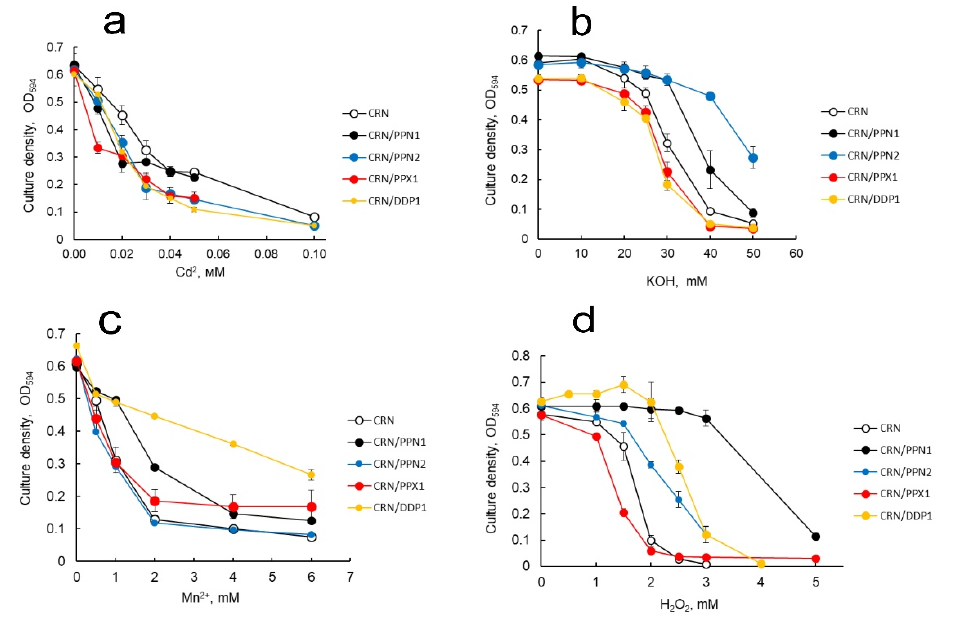
Figure 4. Effects of ( a ) Cd 2+ , ( b ) alkali, ( c ) Mn 2+ , and ( d ) hydrogen peroxide on growth of S. cerevisiae strains overexpressing polyphosphatases Ppx1, Ppn1, Ppn2, or Ddp1 and parent strain CRN. Statistical significance estimates shown in Supplementary Table S2. Two-tailed Student’s t -test was computed in MS Excel software comparing data from each polyphosphatase-overexpressing strain against CRN strain.